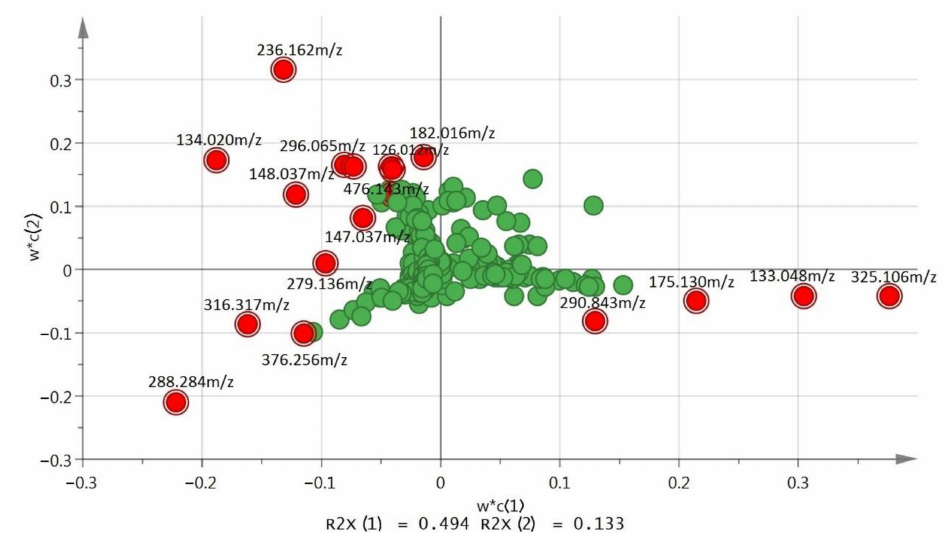
Figure 3. PCA loading plot of control and treated samples that showed the distribution of metabolites (masses) in w*c(1) and w*c(2) planes (green dots). The most important metabolites in VIP list are highlighted in red bulleted dot.